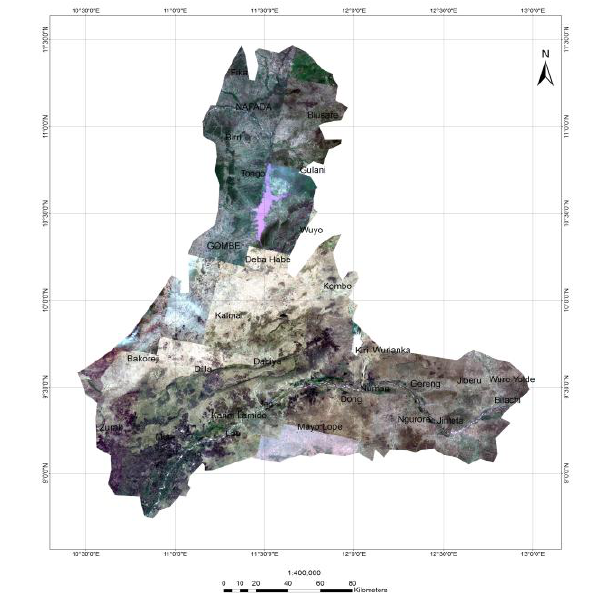
Figure 4. SPOT 5 image of the Upper Benue